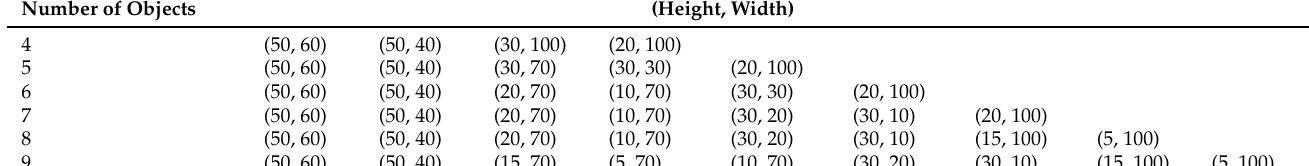
Table 1. Heights and widths of the rectangles used in the sets used in the first study that involves no rotations. Number of Objects (Height, Width)